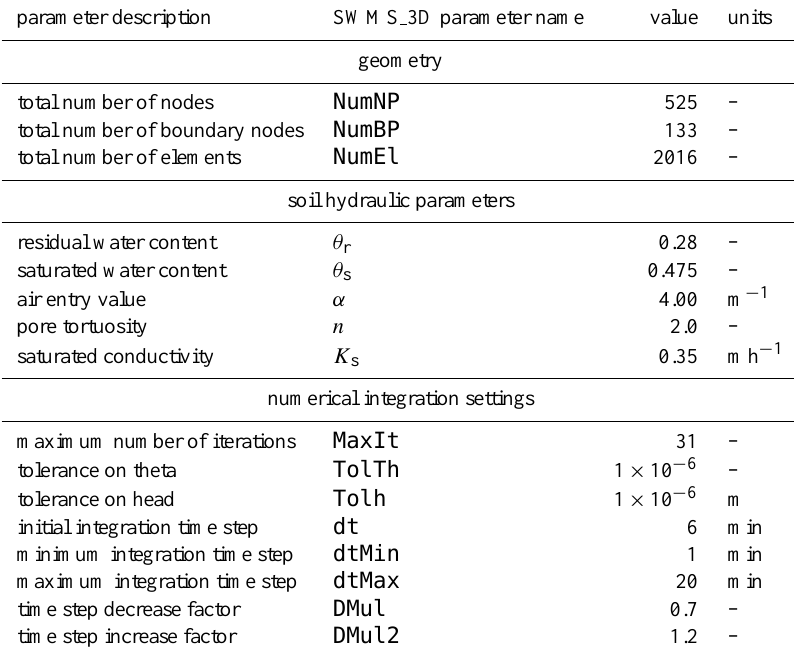
Table 1. Overview of the most relevant parameters in the SWMS 3D